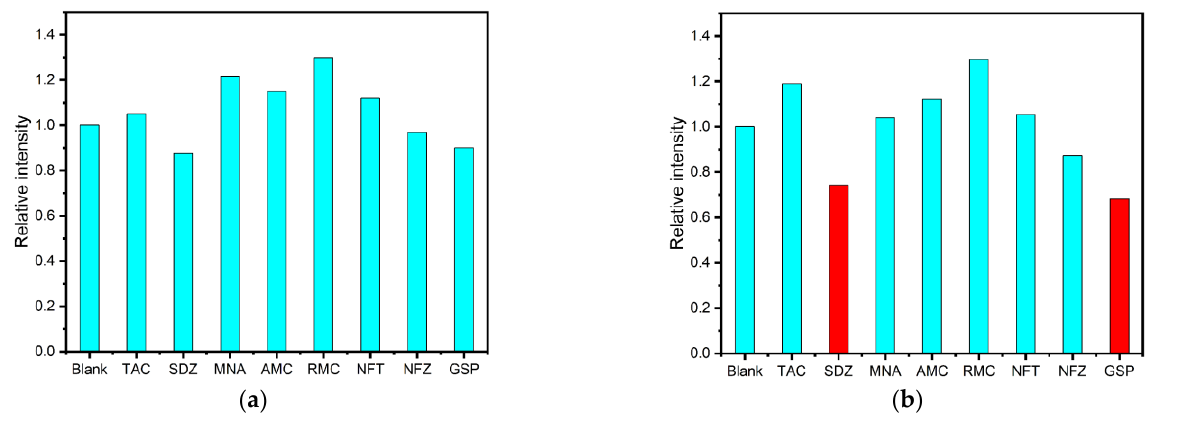
Figure 5. Luminescence intensity of MOF 1 suspension upon addition of different antibiotics and gossypol: ( a ) at 380 nm excitation; ( b ) at 310 nm excitation.